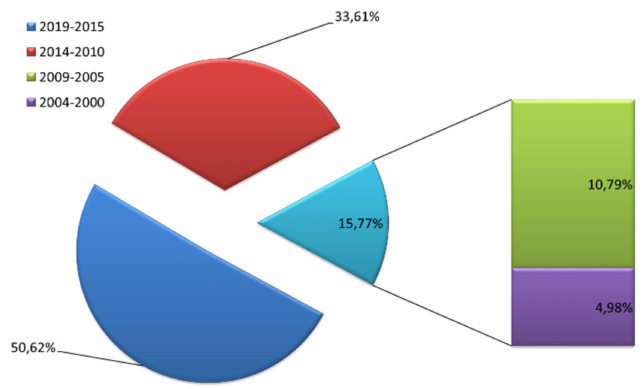
Figure 3. Literature distribution by 5-year